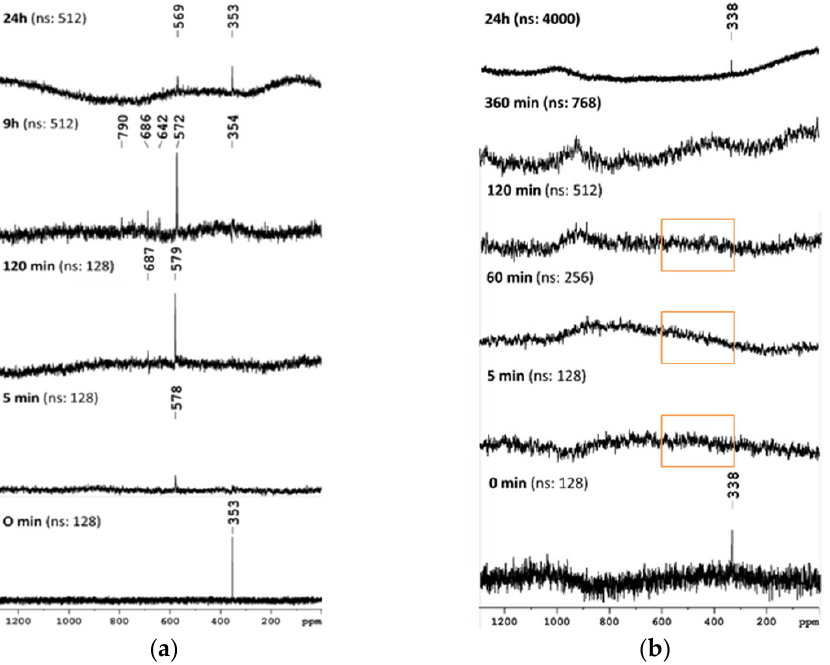
Figure 5. ( a ) Time-dependent 77 Se NMR analysis of the reaction mixtures for the oxidation of Se2U ( 1 , 40 mM) with H 2 O 2 (20 mM) in water and ( b ) phosphate buffer pH 7.4 at 10 °C; 77 Se chemical shifts are marked, and the number of scans is indicated for each spectrum.